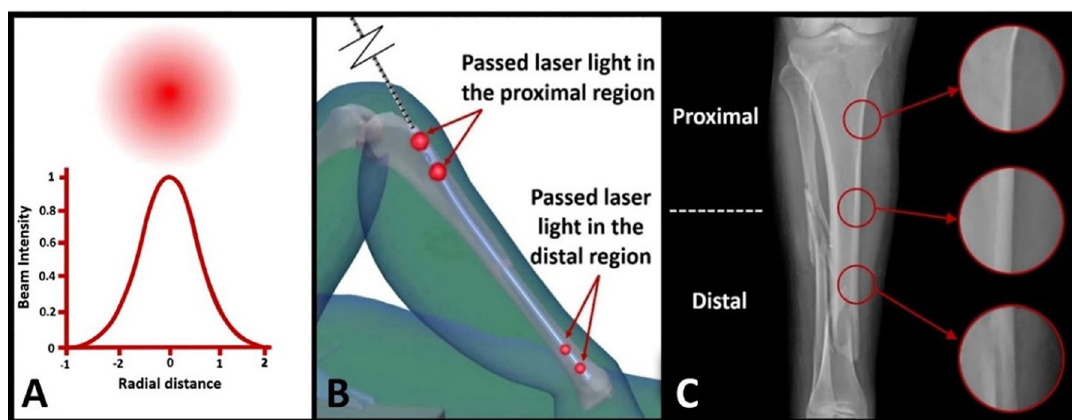
Figure 9 . ( A ) The Gaussian intensity profile of the laser beam, ( B ) the schematic image of the light passing through the nail holes in proximal and distal regions and ( C ) the cortex of the patient tibia bone in three regions before the